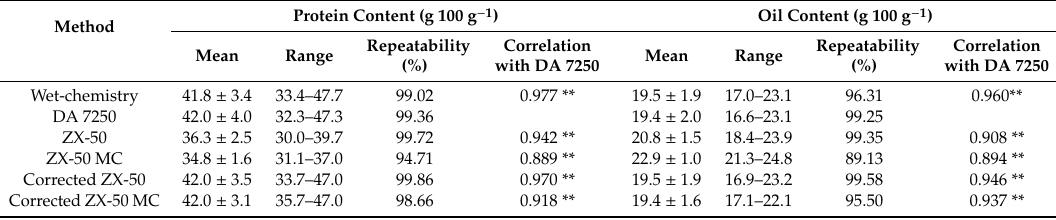
Table 2. Means, range of variation and repeatability of the wet-chemistry and Near-infrared (NIR) analysis methods for soybean seed protein and oil content based on 20 entries and the coe ffi cient of correlation with DA 7250